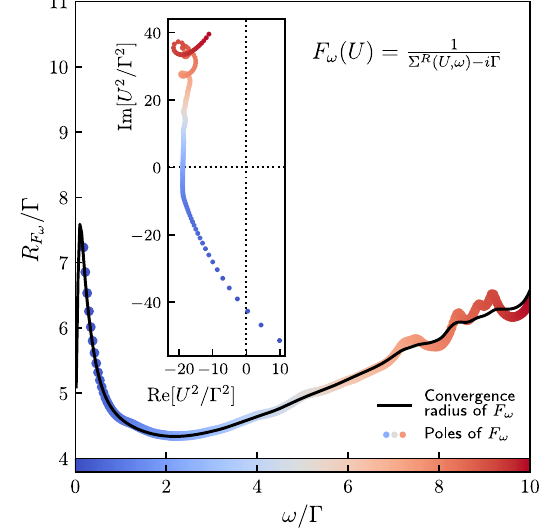
FIG. 7. Main frame: Convergence radius R of F ω ð U Þ ¼ F ω 1 = ½ Σ R ð U; ω Þ − i Γ (cid:2) (thin line) in the equilibrium symmetric Anderson impurity model. The color circles show the absolute value of the pole of F ω ð U Þ . Inset: Position of the pole of F ω ð U Þ in the U 2 complex plane for different frequencies. The color blue to red corresponds to the increasing frequency, as in the main frame. At high frequencies, the statistical uncertainty prevents an accurate localization of the poles. F ω ð U Þ (green symbols) and 1 =F ω ð U Þ (purple symbols). The former is resummed with an Euler transform with a frequency-dependent p set close to the poles shown in Fig. 7. The latter, for which our method does not detect poles, is resummed with the parabola transform (in the U plane) with p ¼ − 4 . 5 Γ . Again, Bayesian inference is G ð U; ω Þ ¼ 0 for all ω ≠ 0 . used to enforce lim U → ∞